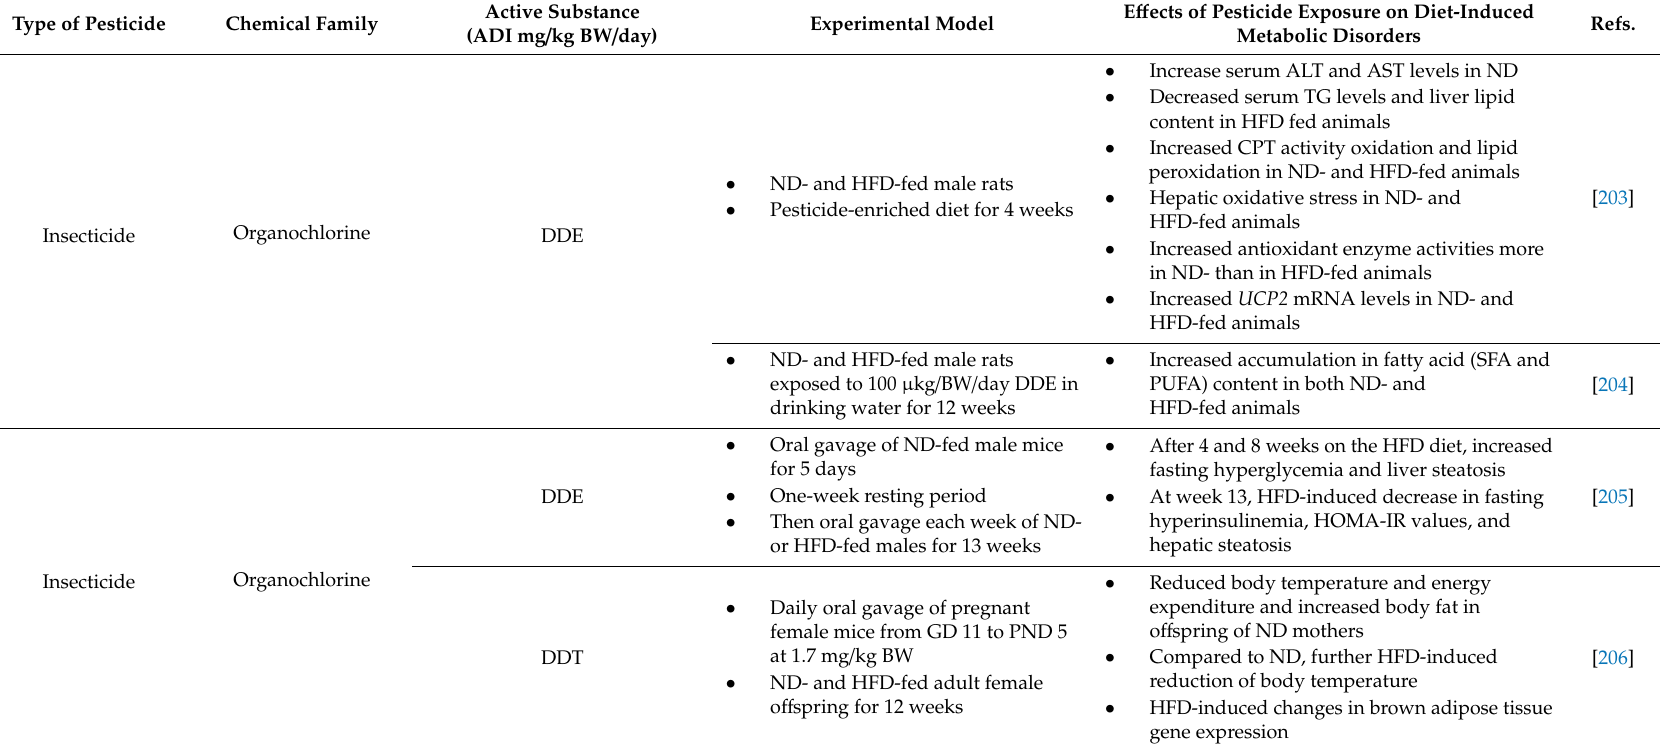
Table 2. Metabolic impact of pesticide exposure in high-fat diet-fed animal models. Acceptable Daily Intake (AD)I values were from https: // ephy.anses.fr / and https: // ec.europa.eu / food / plant / pesticides / eu-pesticides-database / . ADI value is not reported for some compounds due to insu ffi cient data (organochlorine compounds, prinomectin, moxidectin, GW4064, PCB). ALT, alanine aminotransferase; BW, body weight; FFA, free fatty acid; CPT, carnitine palmitoyl-transferase; FXR, farnesoid X receptor; GD, gestational day; GIP, glucose-dependent insulinotropic peptide; GLP-1, glucagon-like peptide-1; HFD, high-fat diet; HOMA-IR, homeostasis model assessment of insulin resistance. NEFA, non-esterified fatty acid; NOAEL, no observable adverse e ff ect level; ND, normal diet; PCB polychlorinated biphenyl; PP, pancreatic polypeptide; PUFA, polyunsaturated fatty acid; PND, postnatal day; SFA, saturated fatty acid; TG, triglyceride; UCP, uncoupling protein; VLDL, Very low density lipoprotein; WT, wild type; ADI, Acceptable Daily